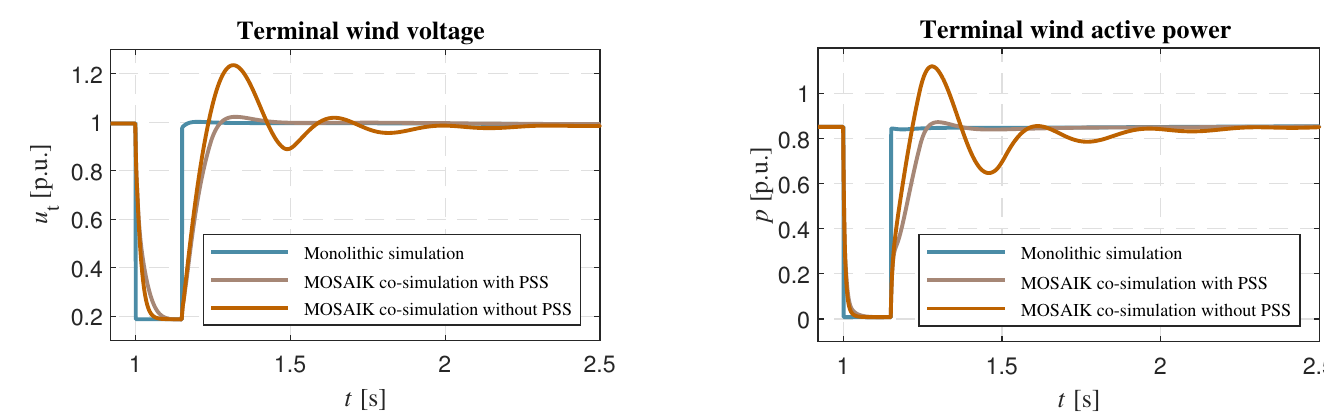
Figure 21. Dynamic response of the wind turbine to the reference fault (weak-grid condition), with and without PSS for the MOSAIK co-simulation.